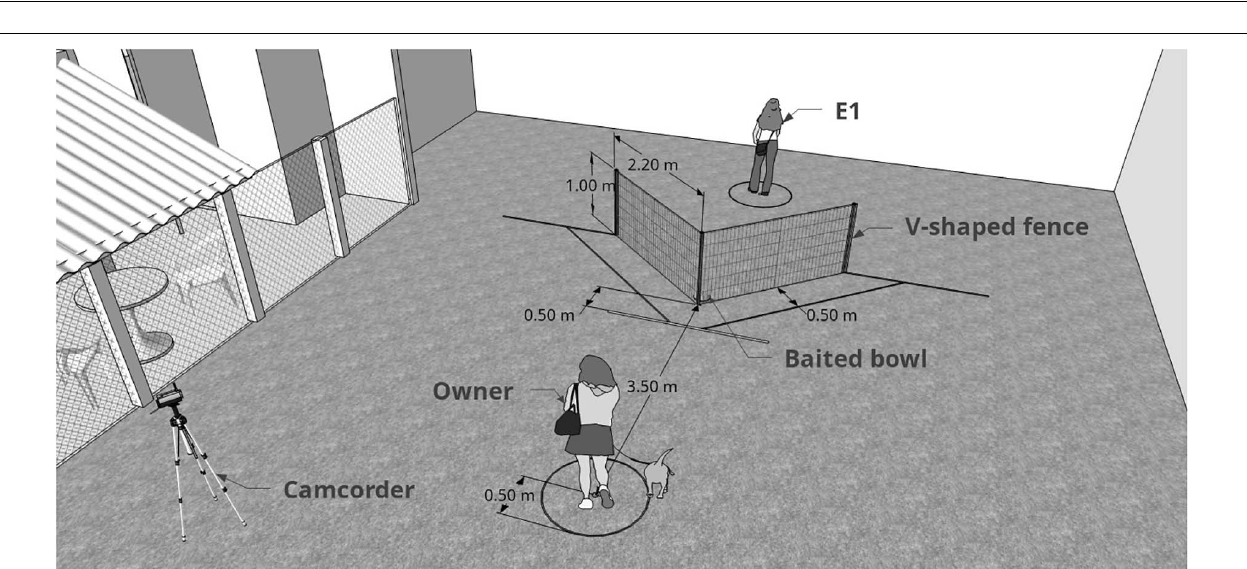
FIGURE 1 | Schematic representation of the experimental area. The emotional display phase happened in Space A, whereas pre-test and test occurred in Space B. Dashed arrows represent the trajectory taken by the owner and dog during pre-test (with the aim of showing the dog the baited bowl placed in the inner vertex of the fence).